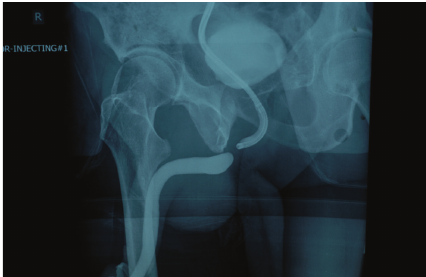
Figure 5: Simultaneous antegrade and retrograde urethral imaging demonstrating a bulbar urethral obliteration, further confirmed with antegrade